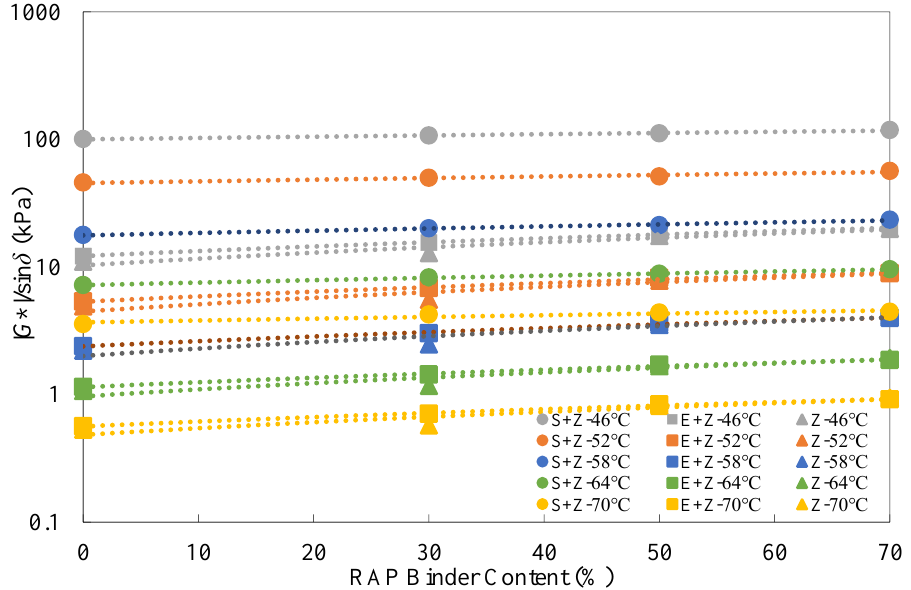
Figure 8. Rutting parameter test results of the warm-mix recycled binders at different RAP binder contents under the short-term aged condition.